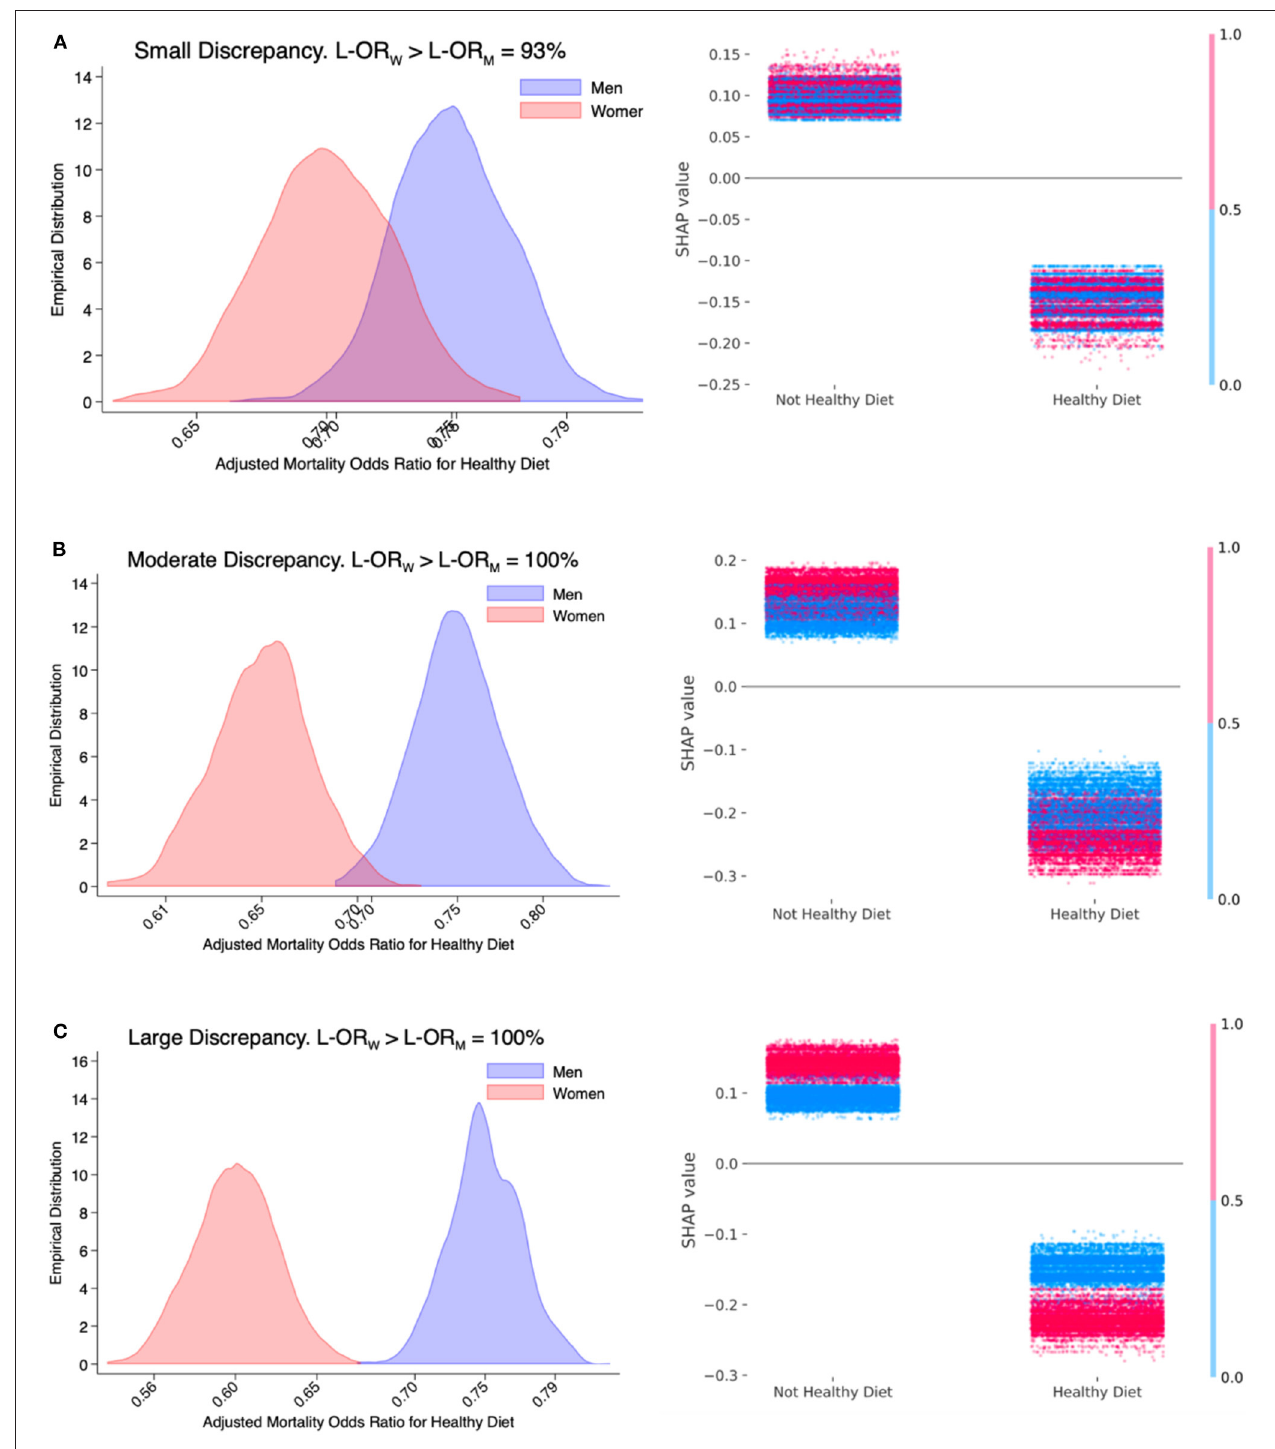
FIGURE 1 | Simulation study—small ( A ; Power = 28%), moderate ( B ; Power = 83%), and large ( C ; Power = 100%) discrepancy by sex in the adjusted mortality odds ratio for healthy diet estimated with a logistic regression model. The left column shows the sampling distribution of the adjusted mortality odds ratio (on the log-scale) conferred by a healthy diet among men and women based on 1,000 simulated studies. The three numbers shown on the x-axis log scale are the 2.5th, 50th, and 97.5th percentiles of the simulated sampling distribution based on a logistic regression model. The percentage indicated in the title is the fraction of studies in which the estimated adjusted mortality odds ratio among women (L-OR W ) is greater than men (L-OR M ). The right column shows individual SHAP values derived from extreme gradient boosting on one random sample drawn from the interaction mechanisms that are presented on the left column.